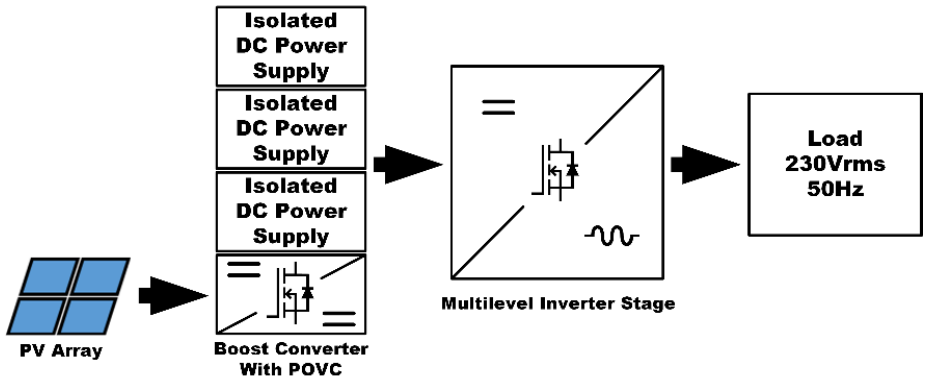
Figure 2. Overview of the proposed standalone PV system.